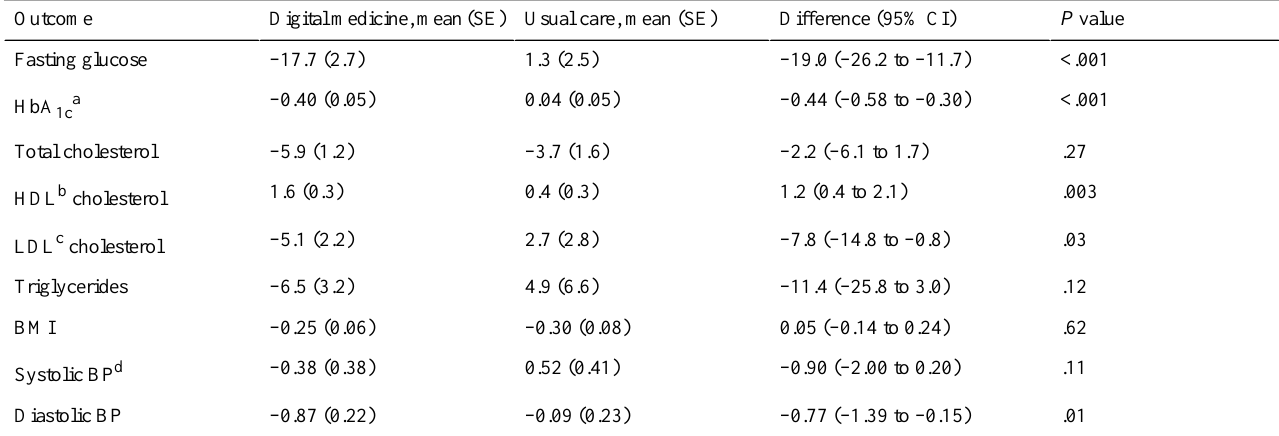
Table 10. Unadjusted mean within-patient change in outcomes by group.